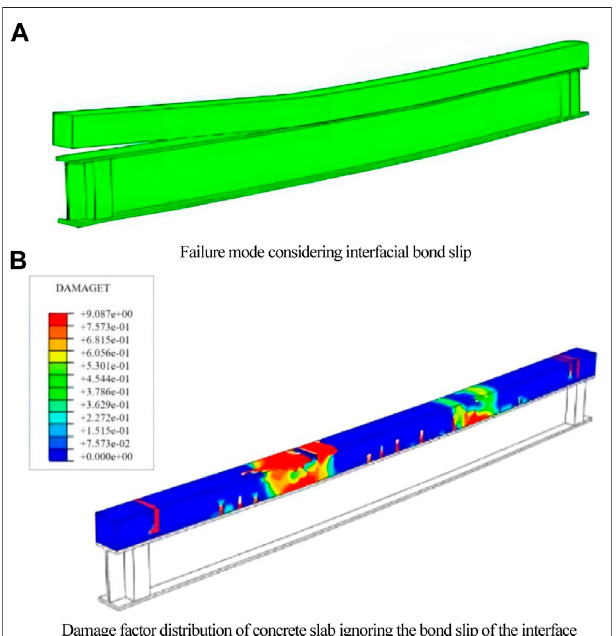
FIGURE 7 | Failure mode of Beam C. (A) Failure mode considering interfacial bond – slip. (B) Damage factor distribution of the concrete slab ignoring the bond – slip of the interface.